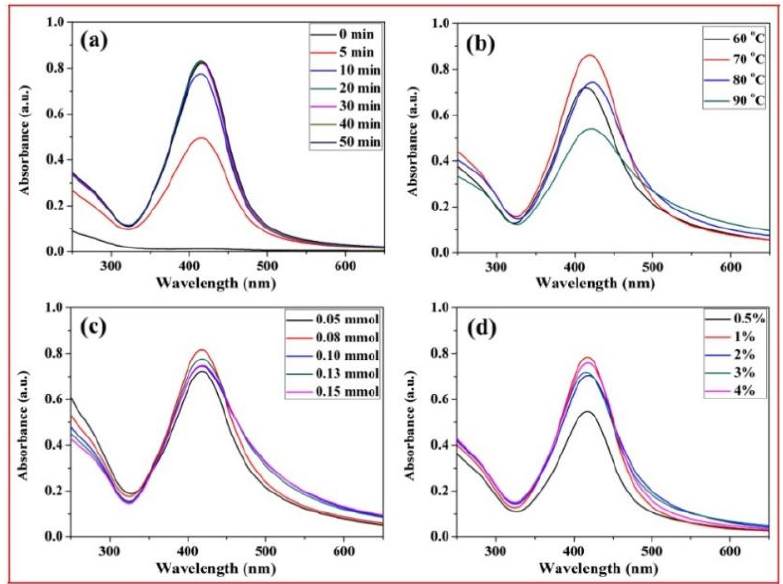
Figure 6. UV-Vis spectrum curves of xylan-click-QCS/AgNP composites under different reaction conditions: ( a ) different reaction time; ( b ) different reaction temperature; ( c ) different Ag + content; ( d ) different ammonia concentration.